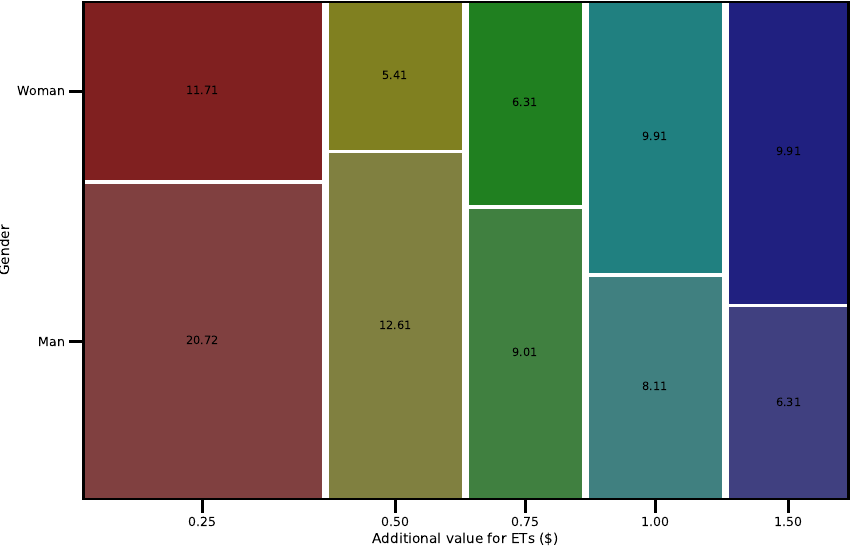
Figure 5. Mosaic plot of the willingness to pay an additional value for ETs based on gender.